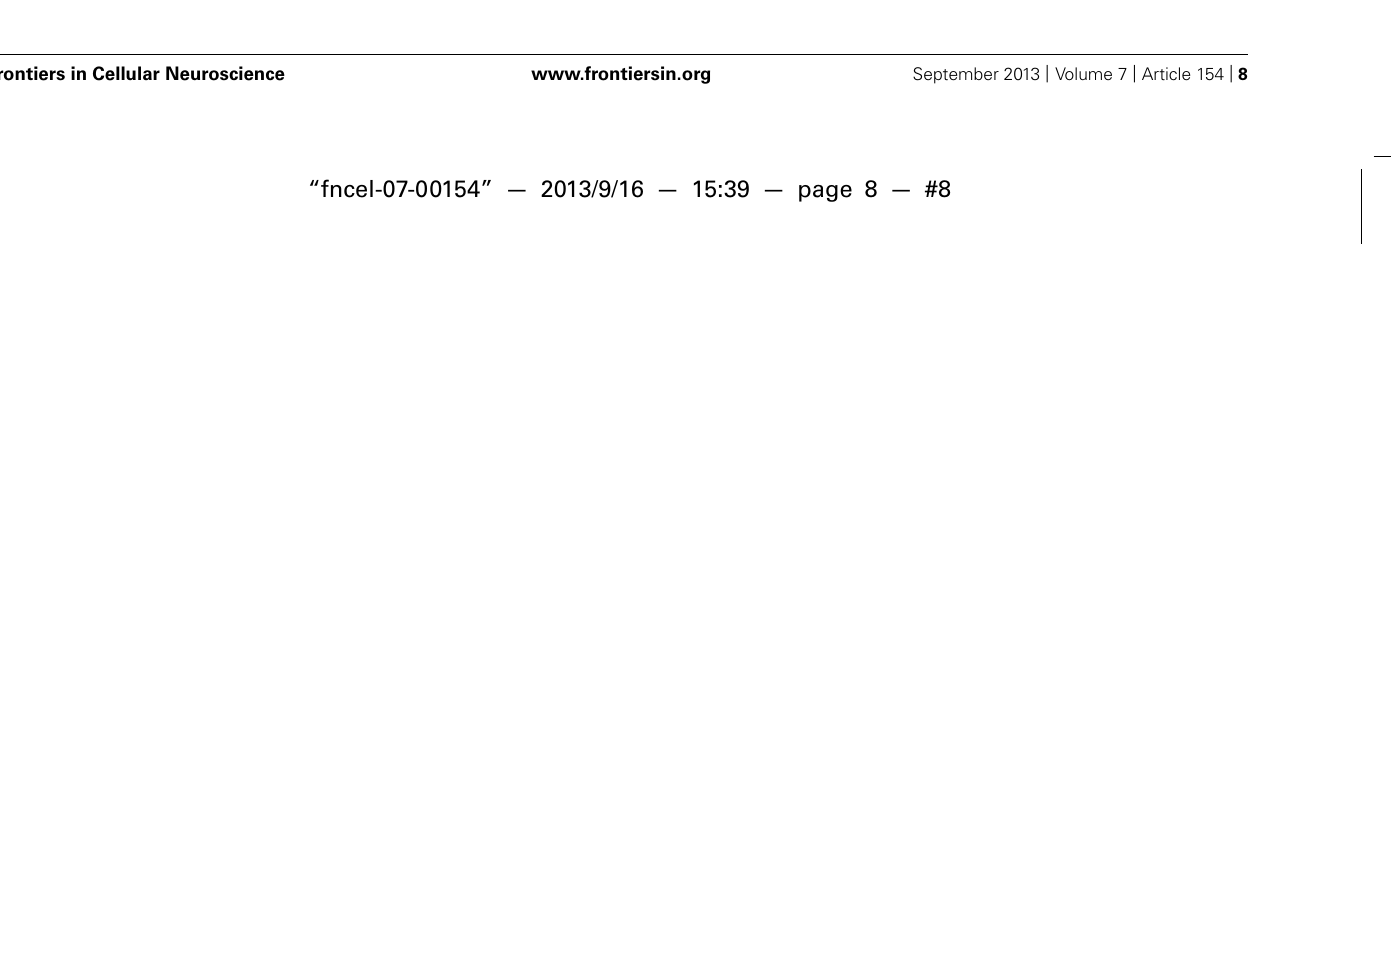
FIGURE 4 |Acute seizure recorded 8 h after the undercut and 6 h after the end of anesthesia. Electrographic seizure starts in the anterior part of the suprasylvian gyrus and then propagates to other cortical areas and hippocampus. Behavioral seizure starts with eye movement and later with muscle contractions. Muscle activity